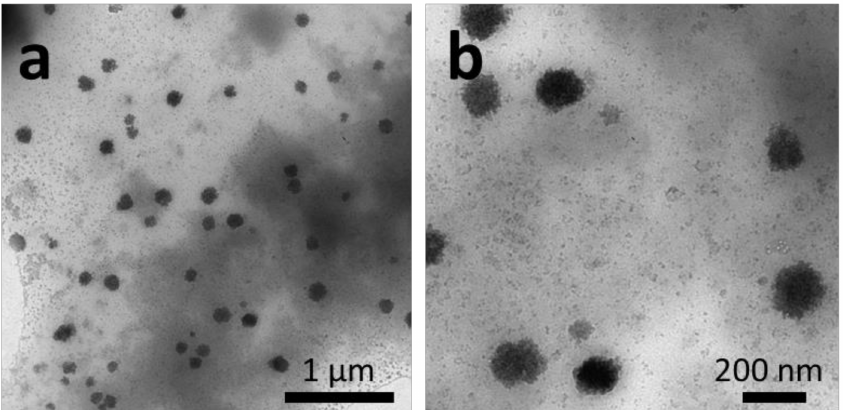
Figure 2. TEM images of the P(VDF- co -HFP)- b -PEG- b -P(VDF- co -HFP) triblock copolymer aggregates formed by thin-film rehydration with water after one week in pure water. Images ( a ) and ( b ) show the aggregates at two di ff erent